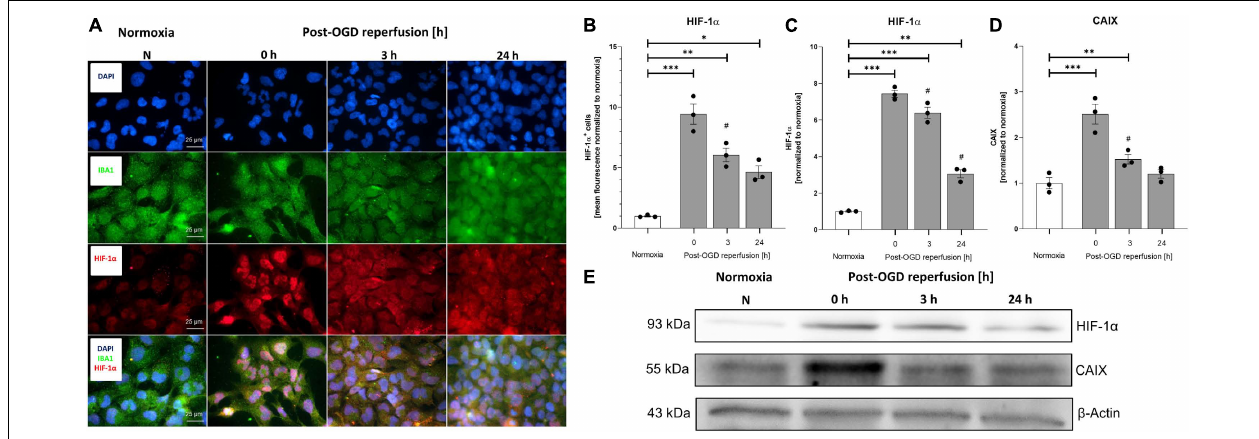
FIGURE 2 | Oxygen-glucose-deprivation (OGD) dependent stabilization of HIF-1 α and upregulation of its downstream CAIX in human HMC-3 microglial cells. HMC-3 cells were subjected to 4 h of OGD followed by a reperfusion period of up to 24 h. (A) Representative immunocytochemistry images of DAPI (blue), IBA1 (green), and HIF-1 α (red) in HMC-3 cells from 3 independent experiments. (B) Mean fluorescence intensity per 1,000 cells of HIF-1 α . Intergroup differences were tested by ANOVA two-way followed by Tukey post hoc test (multiple comparison). Bars represent means ± SD of 3 individual experiments with 3 technical replicates, individual data points are shown. ∗ p < 0.05, ∗∗ p < 0.01, ∗∗∗ p < 0.001 between groups, # p < 0.05 compared to previous reperfusion duration. (C,D) Densitometric quantification of protein levels normalized to normoxia control. β -Actin served as loading control. Intergroup differences were tested by ANOVA two-way followed by Tukey post hoc test (multiple comparison). Bars represent means ± SD of 3 individual experiments, individual data points are shown. ∗ p < 0.05, ∗∗ p < 0.01, ∗∗∗ p < 0.001 between groups, # p < 0.05 compared to previous reperfusion duration. (E) Representative Western blot images of HIF-1 α , CAIX, and β -Actin protein